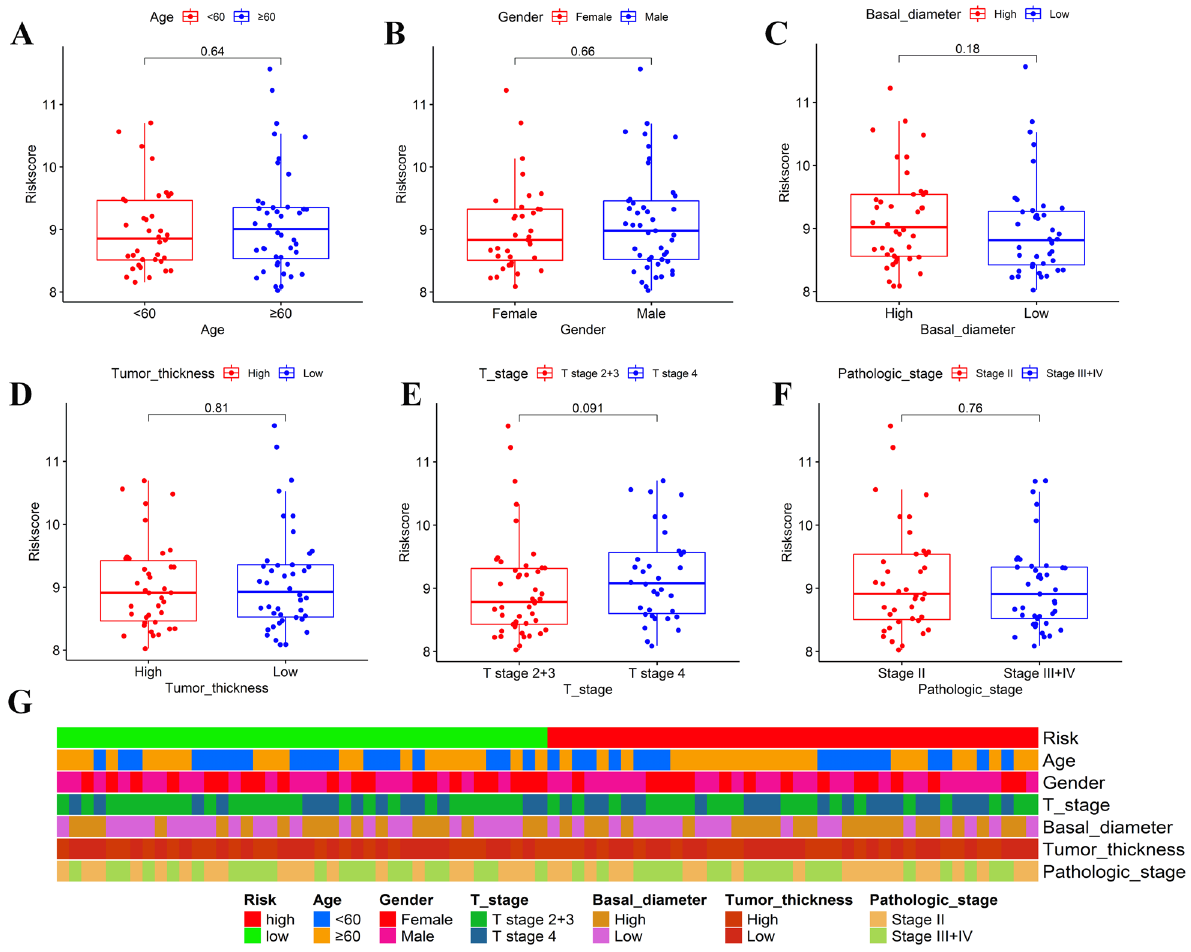
Figure 4. Correlation analysis of the risk score with clinicopathological features. Boxplots of different groups stratified by age ( A ), gender ( B ), basal tumor diameter ( C ), tumor thickness ( D ), tumor T stage ( E ), and pathologic stage ( F ). Heatmap for the connections between clinicopathologic features and the risk groups ( G ). The figure was performed using R software (version 3.3.1, Vienna, Austria, https:// www.r- proje ct. org/).